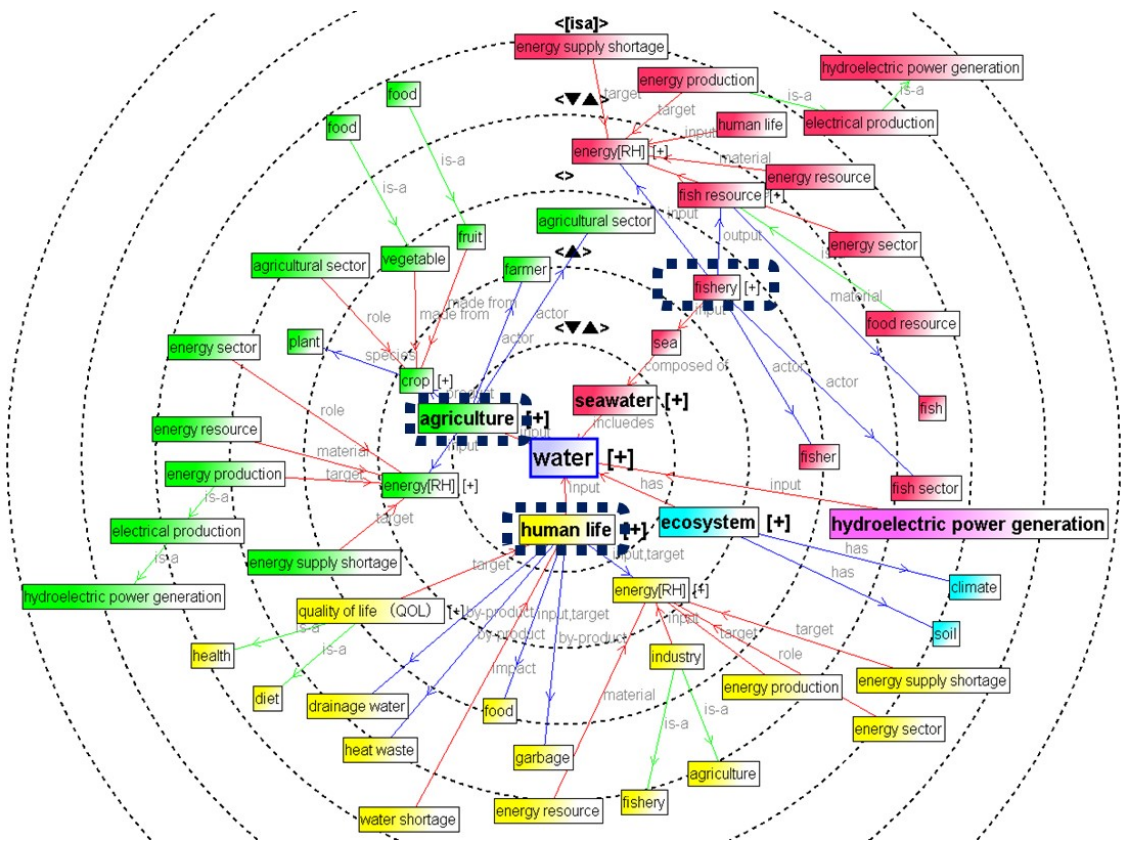
Figure 4. Conceptual map focusing on